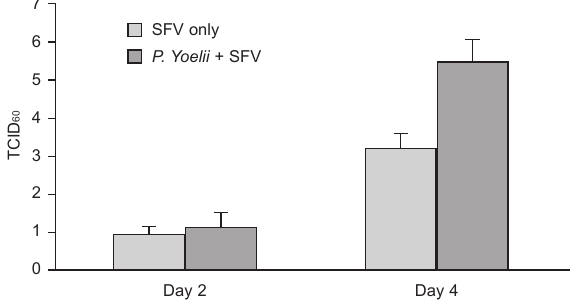
Fig. 1. – Virus titre in mouse brain. (Bar represent ± SE, 10 animals in each group).